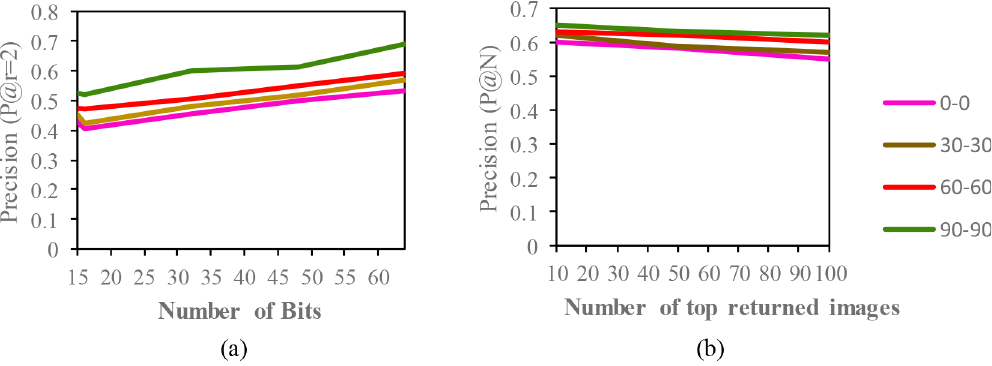
Figure 5. Comparison of the (a) precision curves at a Hamming radius of 2 (P@r = 2) with different bit lengths and the (b) precision curves of the top-N returned images on the OUISIR-MVLP dataset. hamming ranking from the top returned image (10 – 100). The value of curve is falls as the rise of the return images. As seen in curve, the evaluation pair (55° – 55°) recorded the lowest value for 100 returned images. Compared to the other datasets, the MAP of the OUISIR-MVLP datasets is the lowest overall for the training and testing pairs since this dataset has the largest number of subjects. The highest MAP is in the lateral view pair (90° – 90°), and the lowest is in the frontal view pair (0° – 0°) because of its failure to capture the fully gait motion from the front. For the bitwise comparison, the hashing performance is better for 48 bits and 64 bits. As the bit length increases, the MAP also increases for the proposed model. Therefore, the precision curves @ top-N are constructed based on the precision values at 64 bits with different returned images (10, 50, 100), as shown in Figure 5.